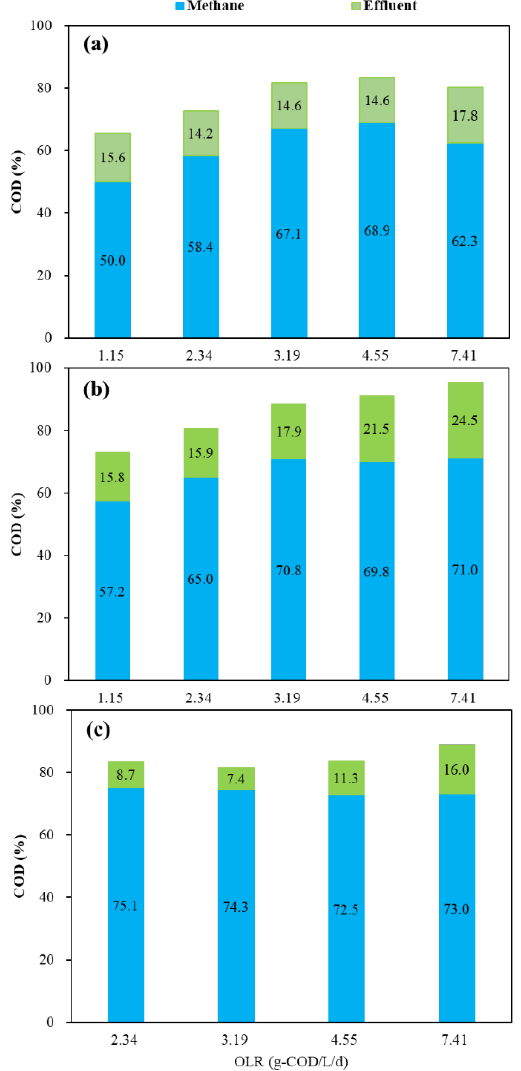
Figure 6. COD balance under different OLR conditions ( a ) mesophilic CSTR, ( b ) thermophilic CSTR, ( c ) thermophilic CSFBR.